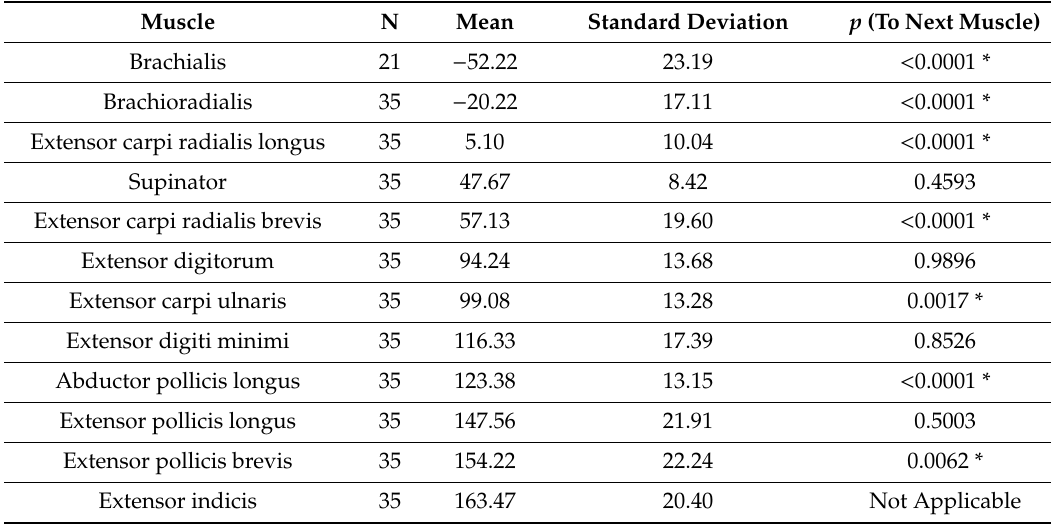
Table 2. Motor entry point order, based on the mean distance in mm from the transepicondylar line to the entry into the muscle (sum of branch distance, above and branch length). p values are listed for the comparison of a mean to the one below it. p values comparing any muscle to another muscle not adjacent to it on this table were all < 0.05.